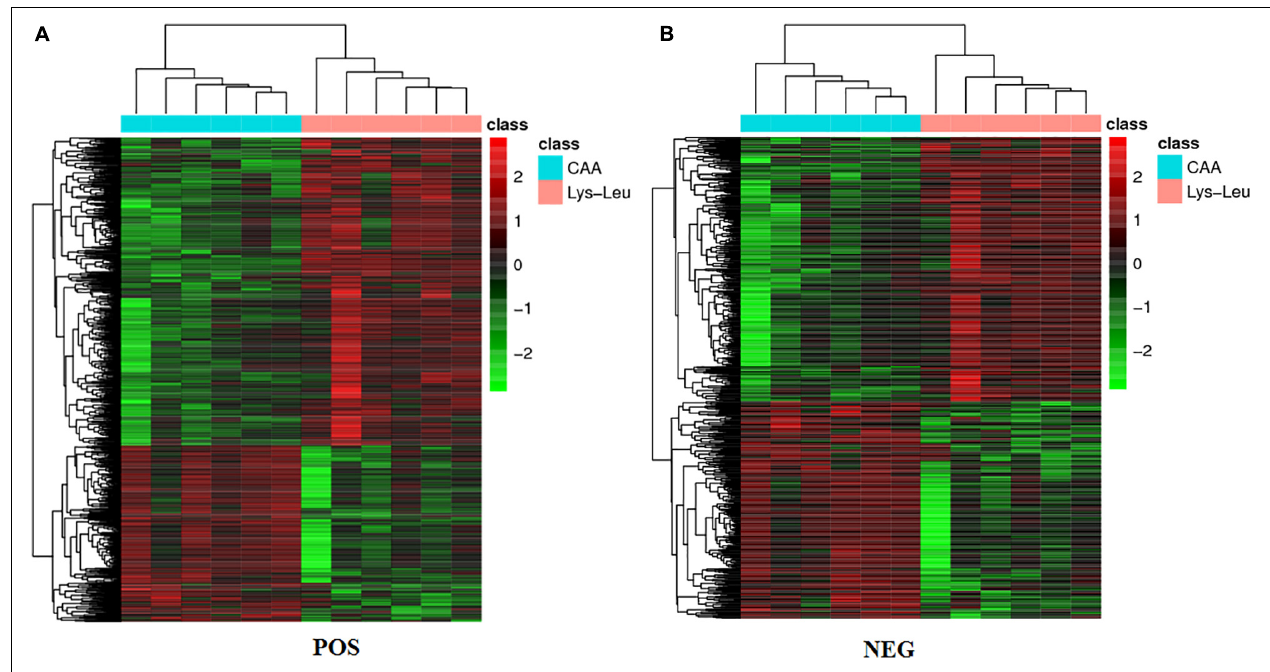
FIGURE 1 | Heat maps of differential metabolites between the CAA and Lys-Leu treatments. (A) The positive ion mode. (B) The negative ion mode. Red color represents the value that is higher than the mean value. Green color represents the value that is lower than the mean value. Black color represents the value that is close to the mean